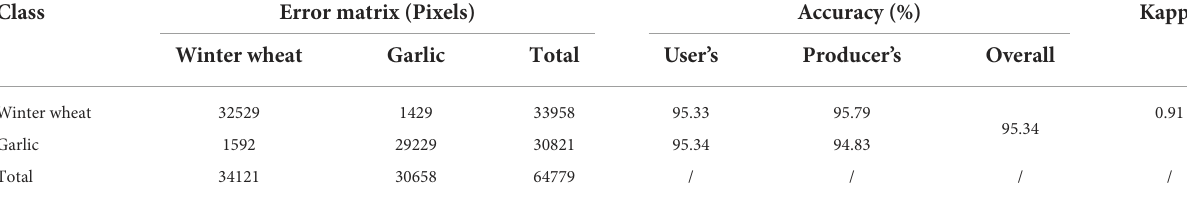
TABLE 3 Results of accuracy validation for the garlic crop based on Sentinel-2 and